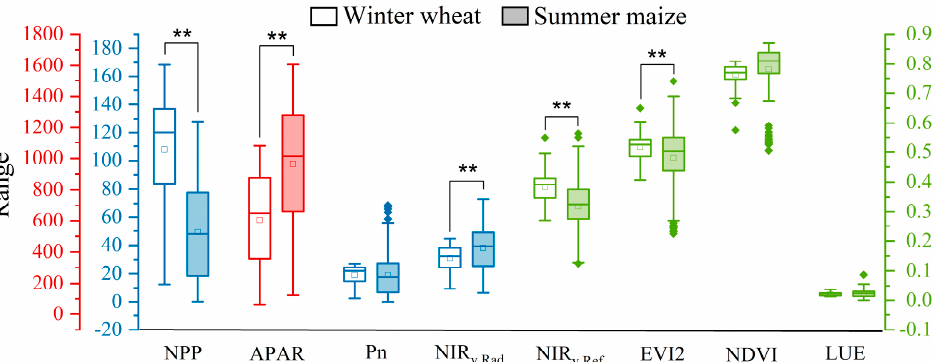
Figure 3. Changes in vegetation and physiological indices on the hourly scale, and difference analysis between winter wheat and summer maize. Box plot colors correspond to those of the coordinate axes. Hollow box plots represent winter wheat, while solid box plots represent summer maize. Asterisk denotes statistically significant differences ** p<0.01.